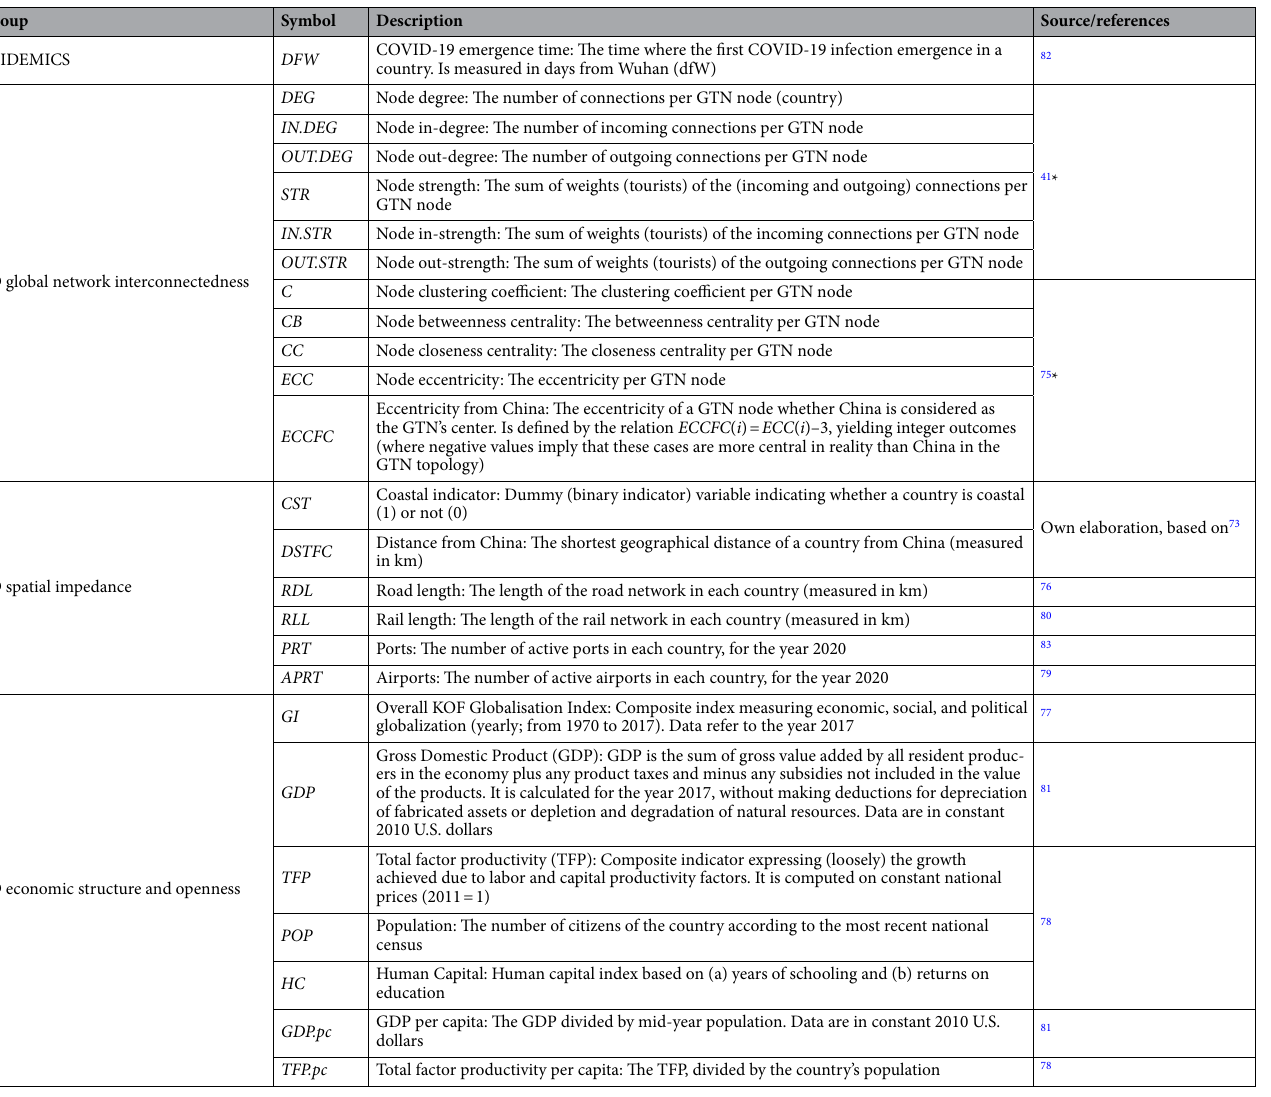
Table 2. Variables participating in the analysis of COVID-19 global spatio-temporal spread. *Own elaboration for the GTN, based on 72 database for the year